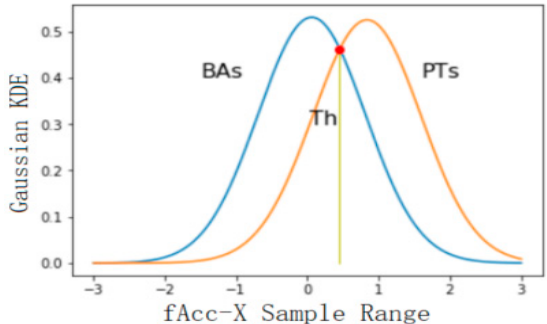
Figure 5. Probability distribution of basic activities (Bas) and postural transitions (PTs).